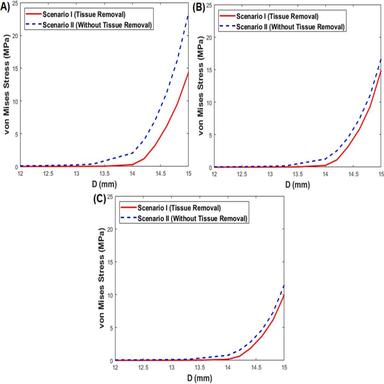
Comparison of von-Mises stresses between two IPP implantation scenarios when neo-Hookean hyperelastic model is used for all tissue layers, (A) point 1 (Inn_CC), (B) point 2 (Out_CC), and (C) point 3 (Mid_TA).